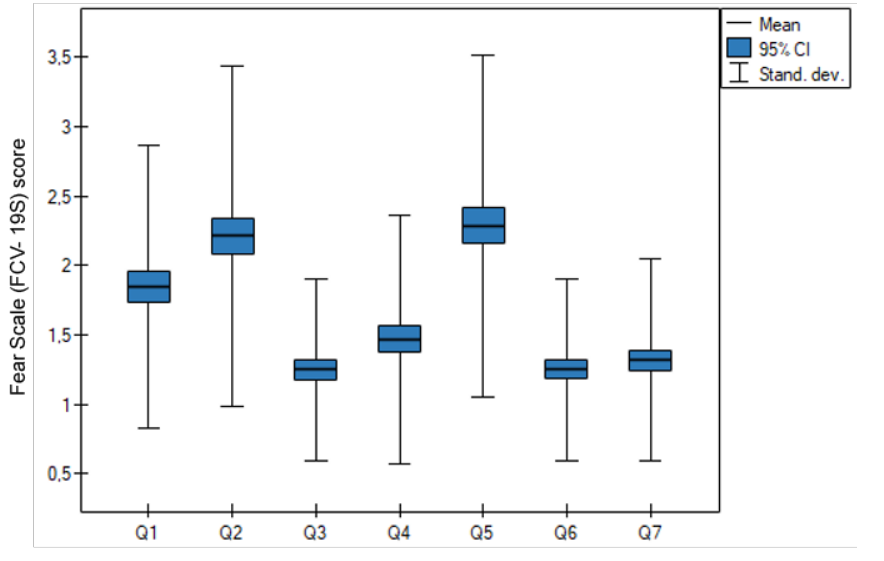
Figure 1. Distribution of responses in the COVID-19 Fear Scale questionnaire (FCV-19S) describing anxiety symptoms.